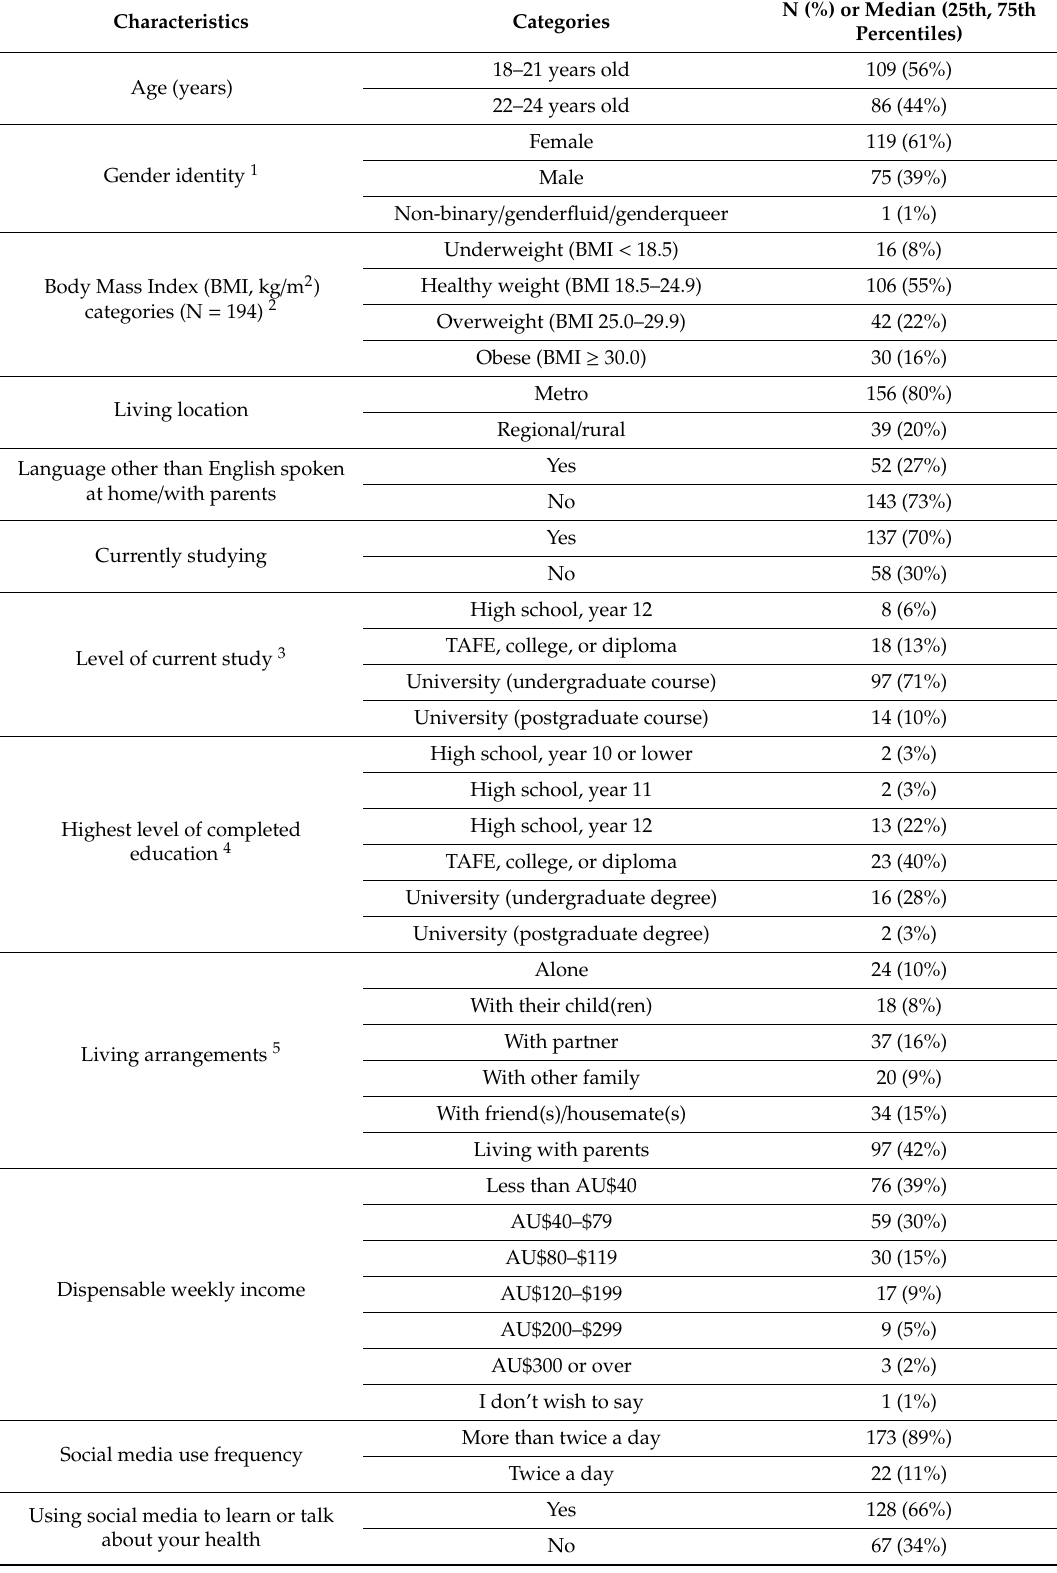
Table 2. Participant characteristics of the online conversations ( n =